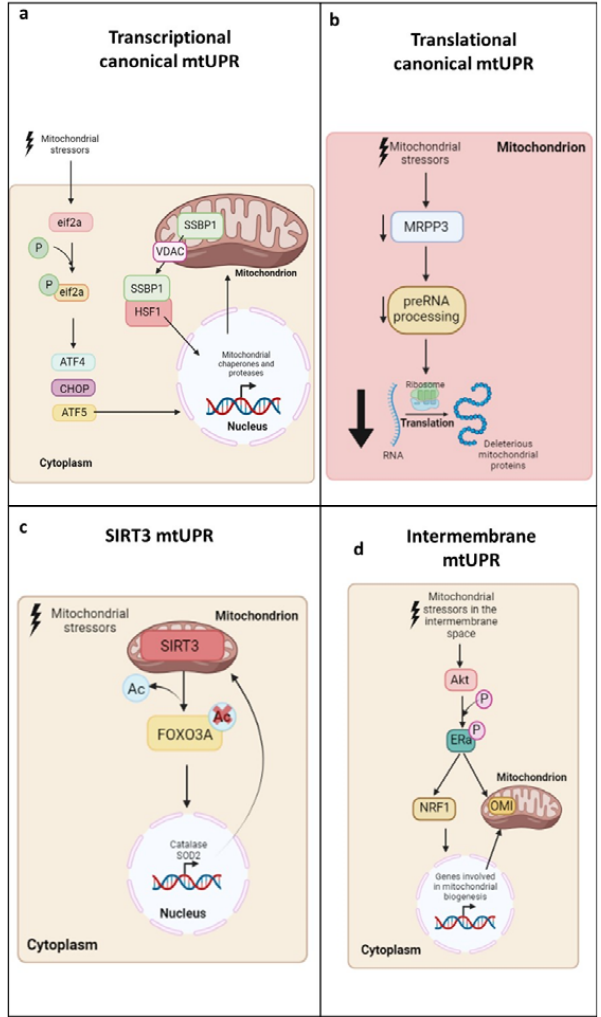
Figure 3. Different axes of the mtUPR in mammals. ( a ) Transcriptional canonical mtUPR. In this pathway, a wide range of stressors provokes the phosphorylation of eif2 α , which promotes the activation of ATF4, ATF5, and CHOP. ATF5, thanks to its NLS, is translocated to the nucleus, where it activates the transcription of mitochondrial chaperones and proteases. Moreover, HSF1 also participates in this pathway since it binds to SSBP1, increasing the expression of mitochondrial chaperones. ( b ) Translational canonical mtUPR. In this pathway, the mitochondrial stressors decrease the MRPP3 Rnase, which is degraded by LonP1. As a result, the processing of the mitochondrial preRNA decreases, as well as mitochondrial translation, preventing the presence of deleterious mitochondrial proteins. ( c ) SIRT3 mtUPR. Here, the deacetylation of FOXO3A by SIRT3 results in its transport to the nucleus, where it activates the transcription of antioxidant enzymes, such as catalase and SOD2 ( d ) Intermembrane mtUPR. When the mitochondrial stressors affect the IMS, a different axis is activated. In this, the phosphorylation of ER α by Akt activates NRF1 and the intermembrane protease OMI, promoting mitochondrial biogenesis and the degradation of aberrant proteins,